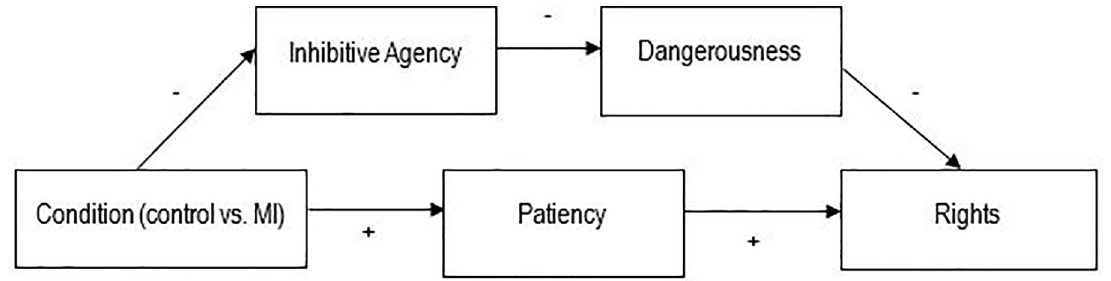
Fig 5. Indirect effect model that will be tested in the registered